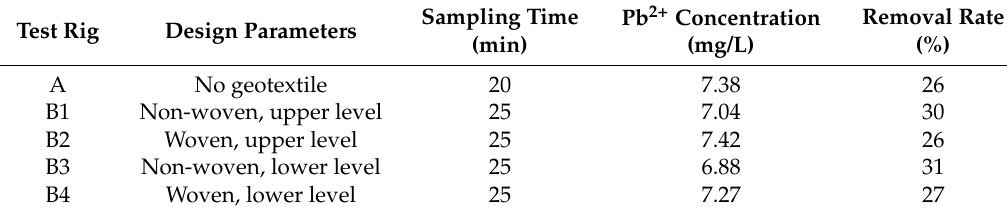
Table 3. Experimental data of initial